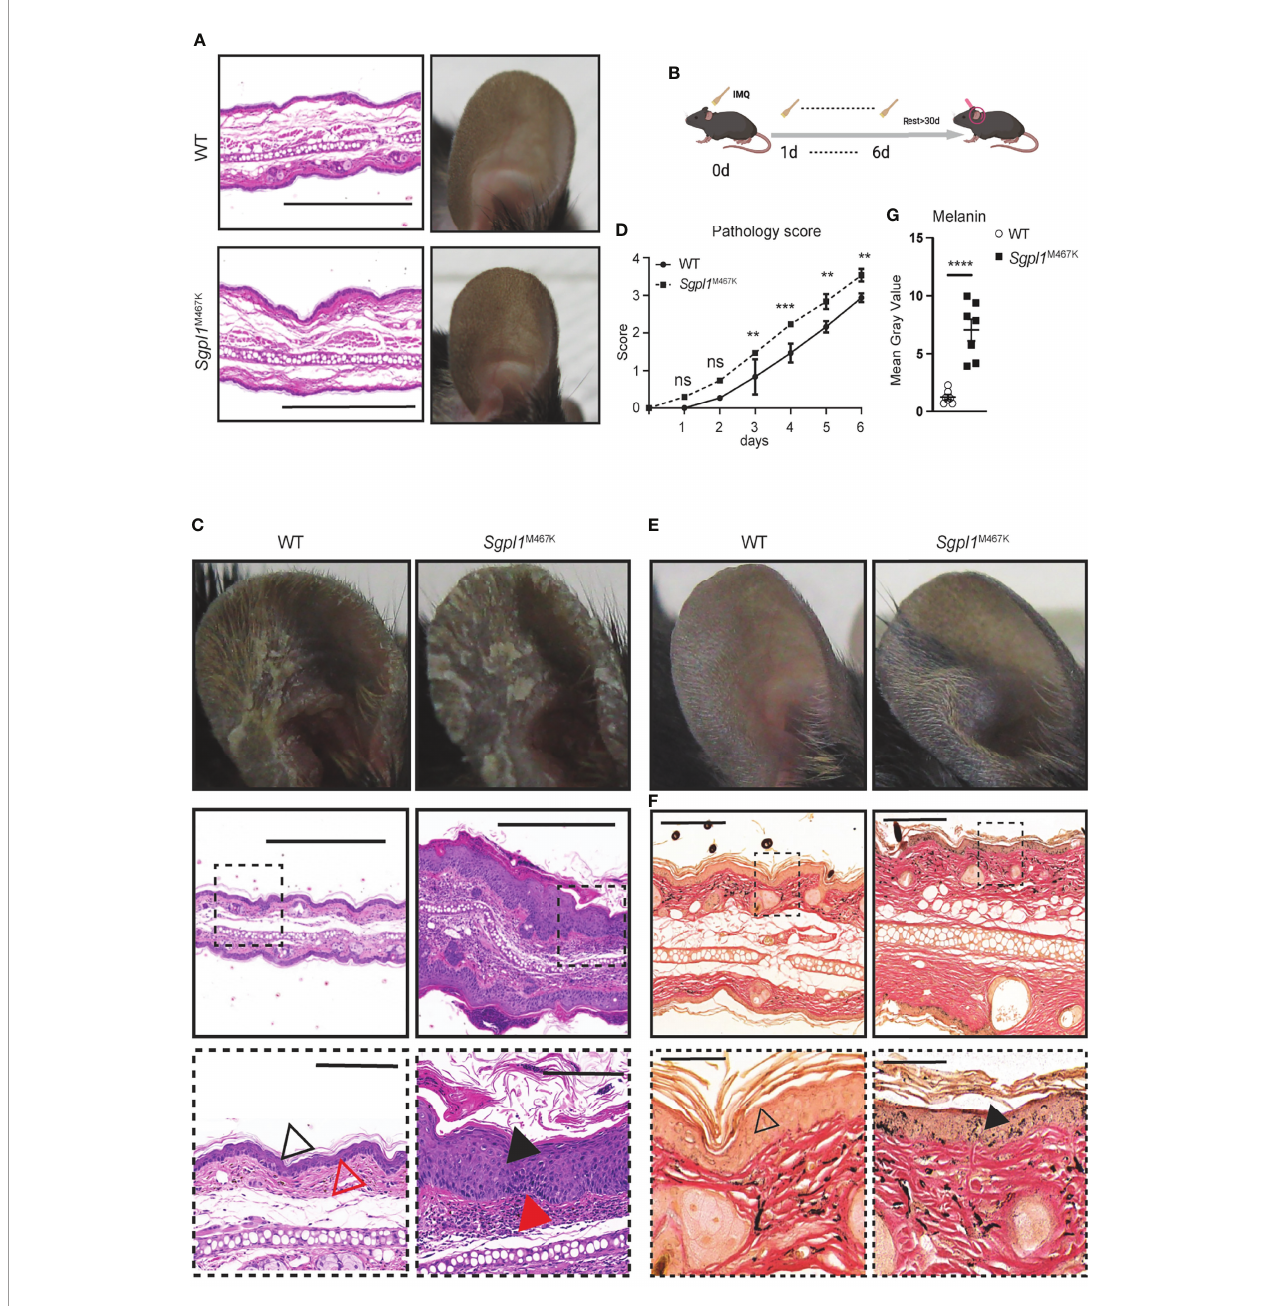
FIGURE 2 | Sgpl1 M467K mice exhibit severe cutaneous pathology after IMQ treatment. (A) Ear images of WT and Sgpl1 M467K mice in steady-state. Left, H&E staining, scale bar, 500µm; right, ear photo. Representative image from ≥ 3 mice of each genotype. (B) Experiment fl ow chart for IMQ application; IMQ was applied on the mouse ear from day 0 to day 6 and the thickness, erythema, and scaling score of the treated ear were recorded each day; ear hyperpigmentation was checked after more than 30 days. (C) Ear images of WT and Sgpl1 M467K mice at day 7 of IMQ induction. Top, ear photo; middle and bottom images, H&E stained; bottom images were enlarged from square marked middle regions, middle and bottom images scale bars represent 500µm and 100µm, separately; black triangle, epidermis, and acanthosis; red triangle, the dermis. Representative images were depicted from ≥ 6 ears per genotype. (D) The pathological pattern was determined by ear thickness, erythema, and scaling score of each experimental day (for each category please refer to Supplement Figure S1 , details see Materials and Methods ). Experiments were repeated fi ve times with three mice from each genotype, one was chosen as representative. ****, p<0.0001; ***, p<0.001; **, p<0.01; ns, not signi fi cant; analyzed with two-way ANOVA. (E, F) Representative ear images, 30 days IMQ-treatment cessation; (E) ear photo. (F) Fontana-Masson stained ear section; bottom images were enlarged from top ones, triangle pointed to epidermal melanin. Representative images from ≥ 6 ears per genotype. (G) Melanin content was assessed from the epidermal region of seven randomly selected independent Fontana-Masson stained sections (see Materials and Methods ). ****, p<0.0001, unpaired t-test, error bar represents